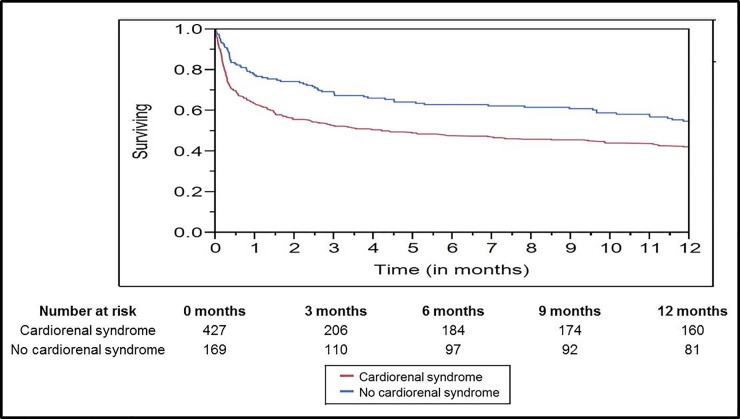
Kaplan-Meier survival analysis for cohorts with and without cardiorenal syndrome.Log-rank test p = .001.